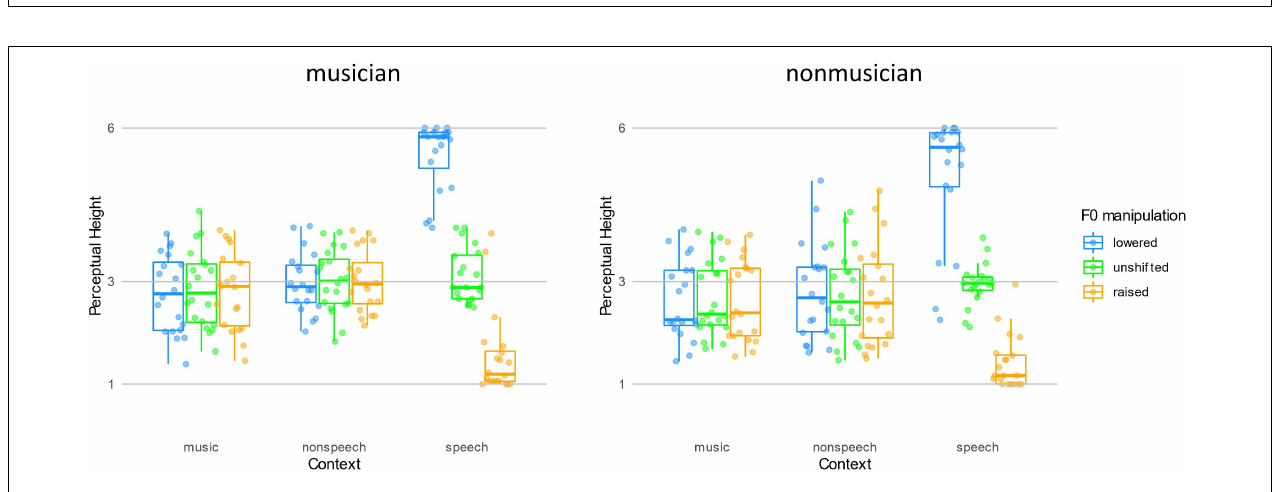
FIGURE 2 | The response rates of high, middle, and low-level tones in isolated and three context conditions. Error bars represent standard error.